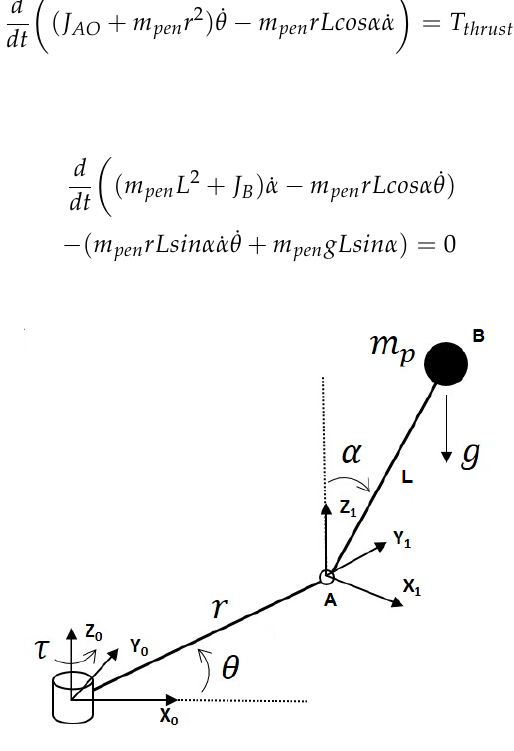
Figure 1. Free body diagram of the rotary inverted